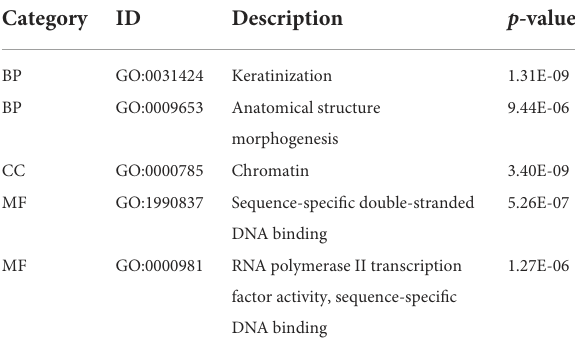
TABLE 3 Top 3 GO enrichment of